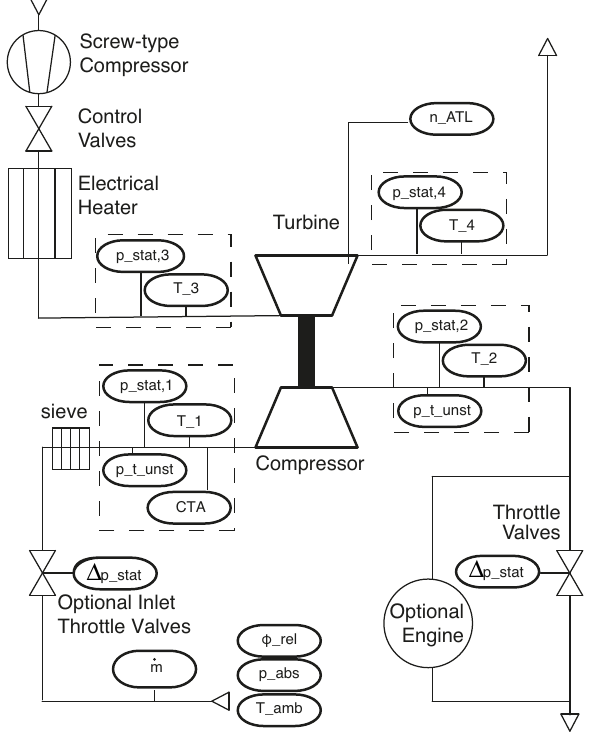
Figure 1. The turbo charger test rig and measurement planes at TU